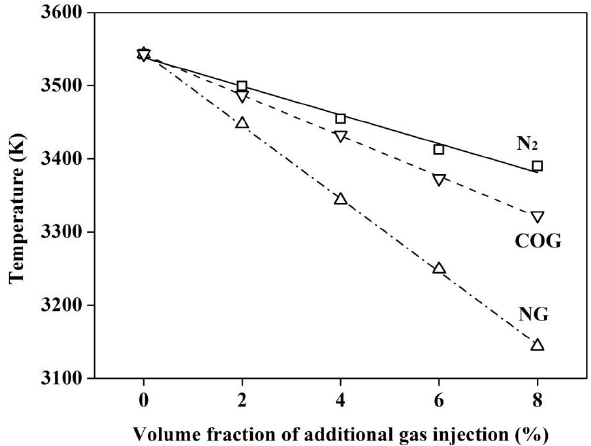
Figure 6: Effect of volume fraction of additional gas injection on highest gas temperature in